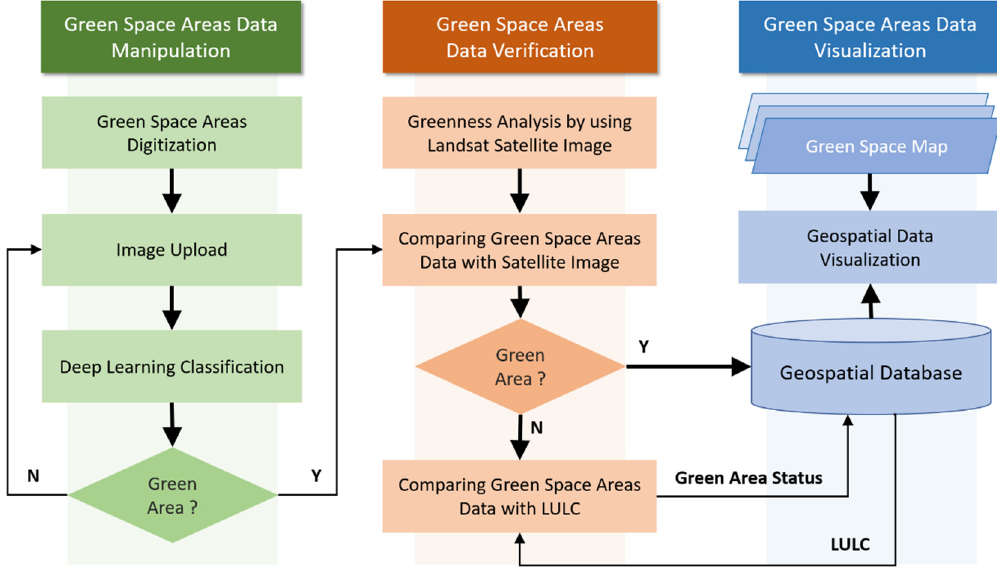
Figure 1. Flowchart of proposed geospatial platform.